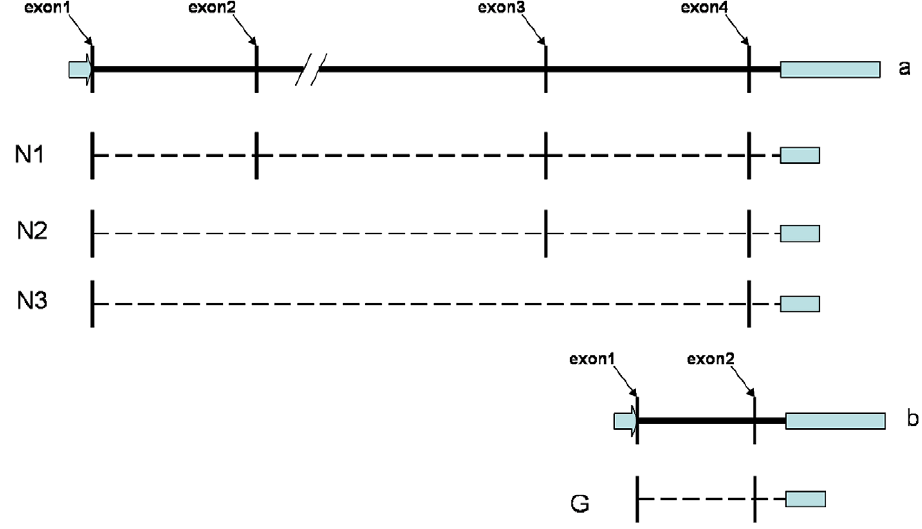
Fig. 1B. Transcripts of human IL-13Ra2 based on splicing of 5 (cid:2) flanking regions. (a) Transcripts (N1, N2, N3) under the control of promoter N. (b) Transcript G under the control of promoter